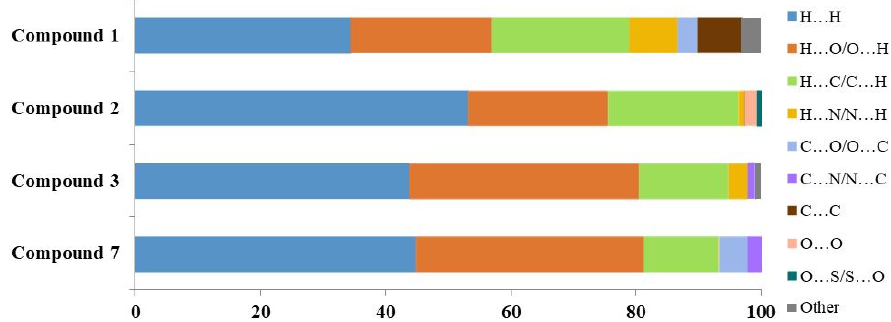
Figure 10. The relative contributions of different types of intermolecular interactions on the basis of Hirshfeld surface analysis of 1–3 and 7 .